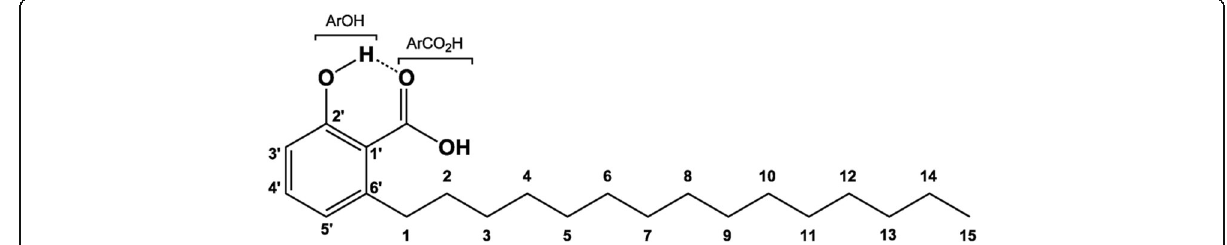
Fig. 2 Chemical structure of LDT11